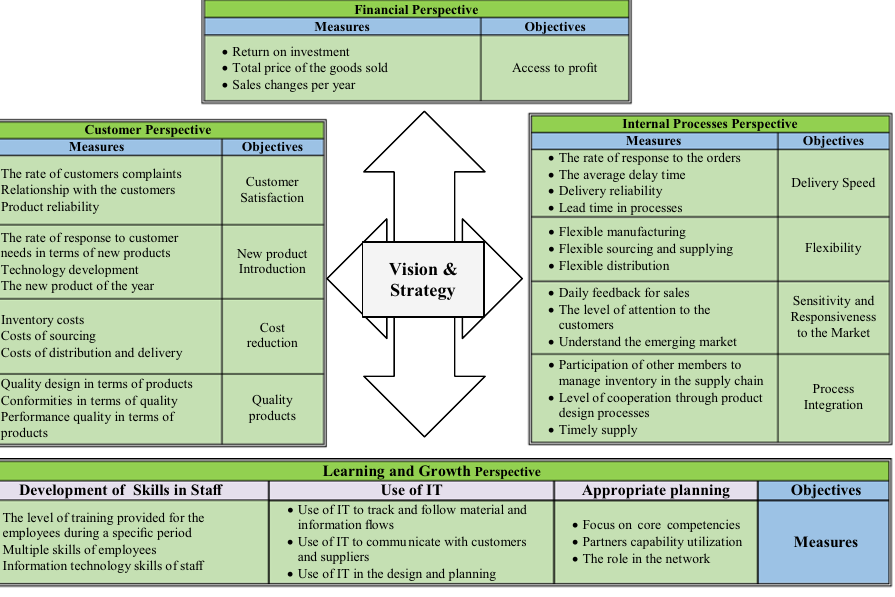
Fig. 2. Agility factors identified by authors through literature